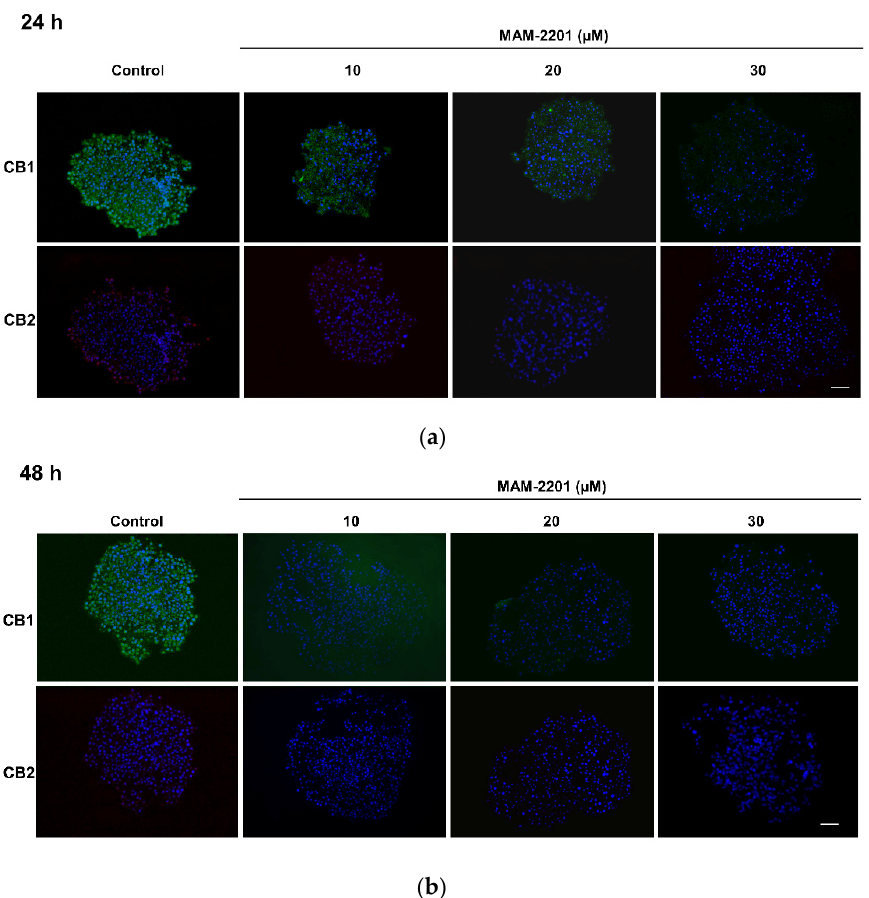
Figure 10. Immunofluorescence analysis of the cannabinoid receptor expression in astrocyte spheroid section after ( a ) 24 and ( b ) 48 h of exposure to MAM-2201. A loss of the fluorescence signal of CB1 (green fluorescence) was observed in D384 spheroid sections, starting at 20 µM after 24 h and starting at 10 µM after 48 h. CB2 showed very low levels of the fluorescence intensity (red) in both the D384 spheroid control and treated spheroids after 24 h, which disappeared after 48 h in treated D384 spheroids. Nuclei were stained with Hoechst 33258. Scale bar: 100 µm.